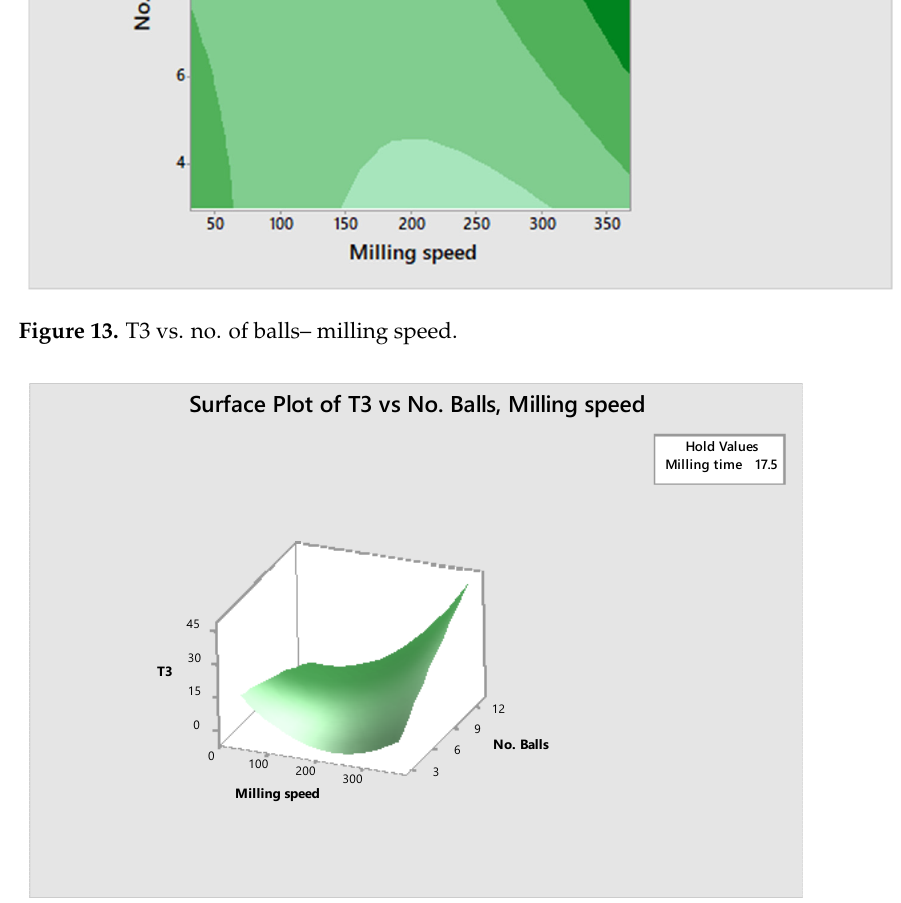
Figure 14. T3 vs. milling speed vs. no. of balls.